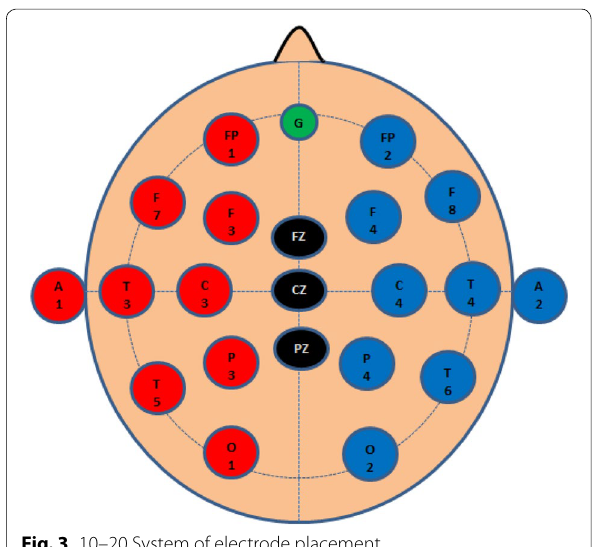
Fig. 3 10–20 System of electrode placement